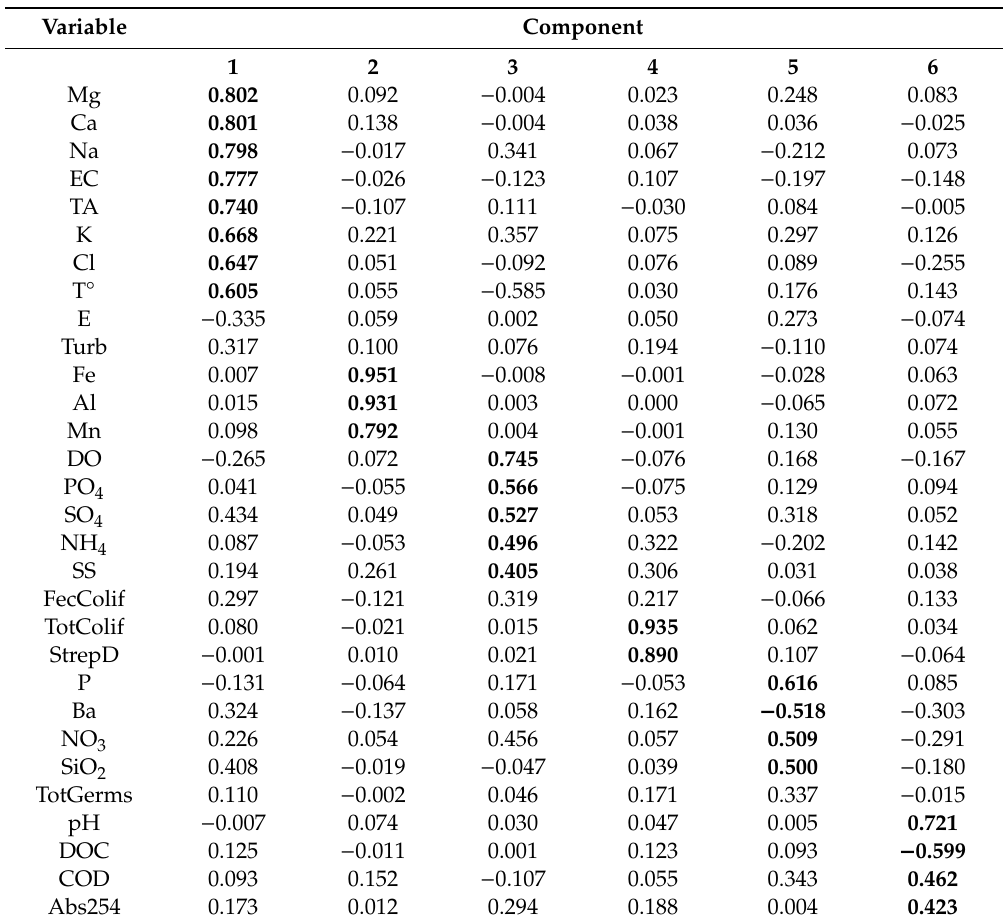
Table 3. Matrix of the first six components obtained for the PCA applied to the data matrix including the two rivers, all variables and all sites excluding KA5 and